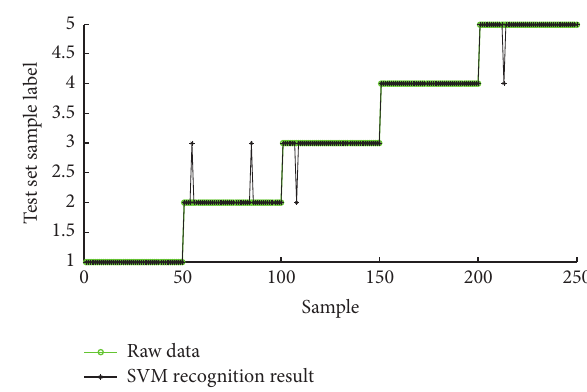
Figure 12: Degradation state recognition results for single domain degradation feature.